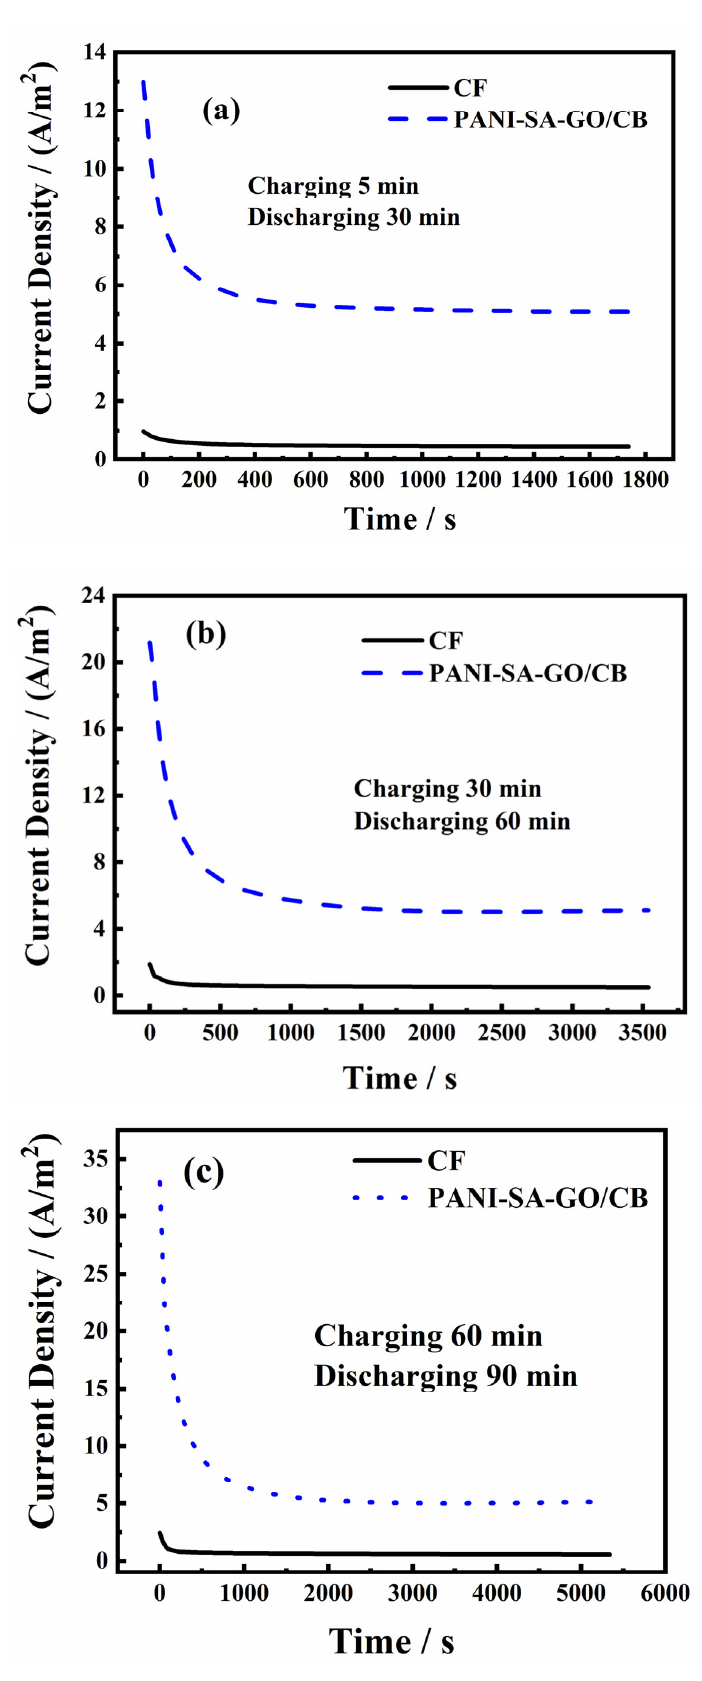
Figure 5. Discharge curves ( a – c ) tested at − 0.1 V for two anodes. (The MFCs were under the closed-circuit condition).